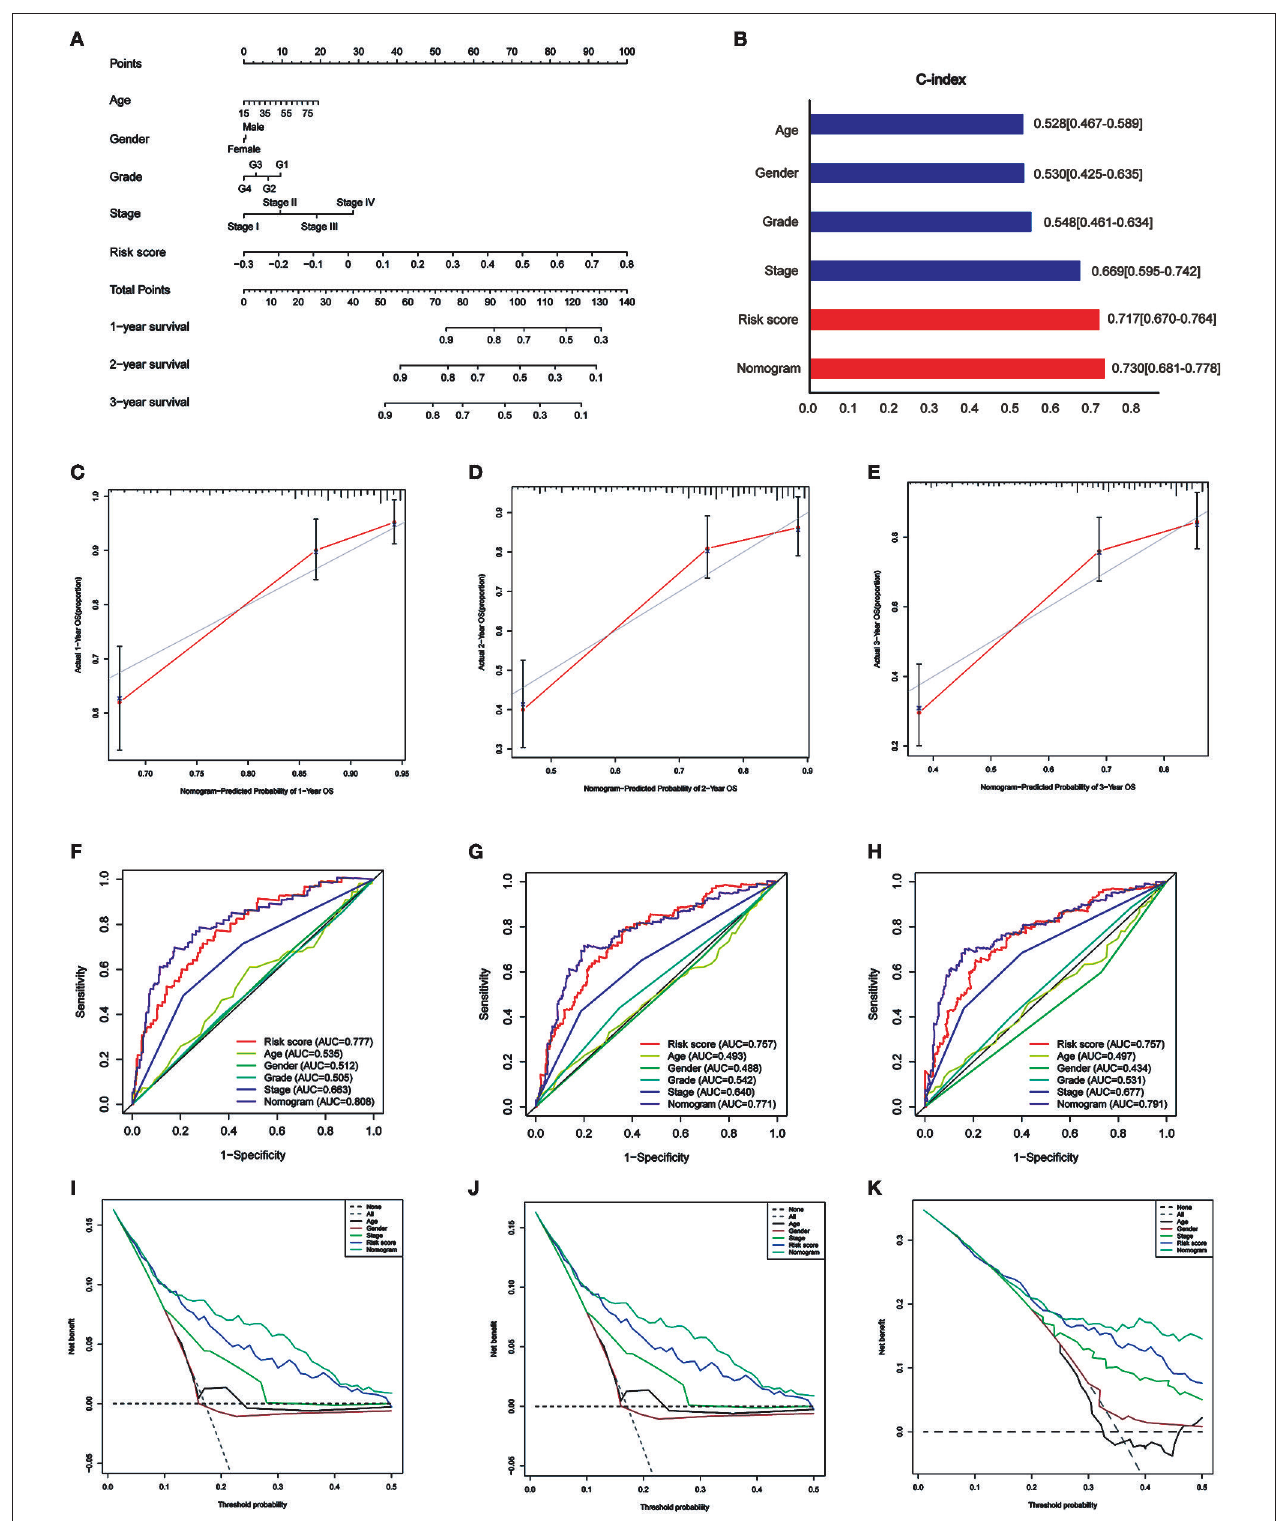
FIGURE 9 | Development of a nomogram in the TCGA set. (A) Nomogram for predicting the survival of patients with HCC. (B) Comparison of C-index among the risk score, nomogram, and clinical features (age, gender, grade, stage). (C–E) The calibration curves for predicting the 1-, 2-, and 3-year OS of the nomogram. Comparison of ROC (F–H) and decision curve analysis (I–K) among the nomogram, risk score, age, gender, grade, and stage with respect to the 1-, 2-, and 3-year OS.